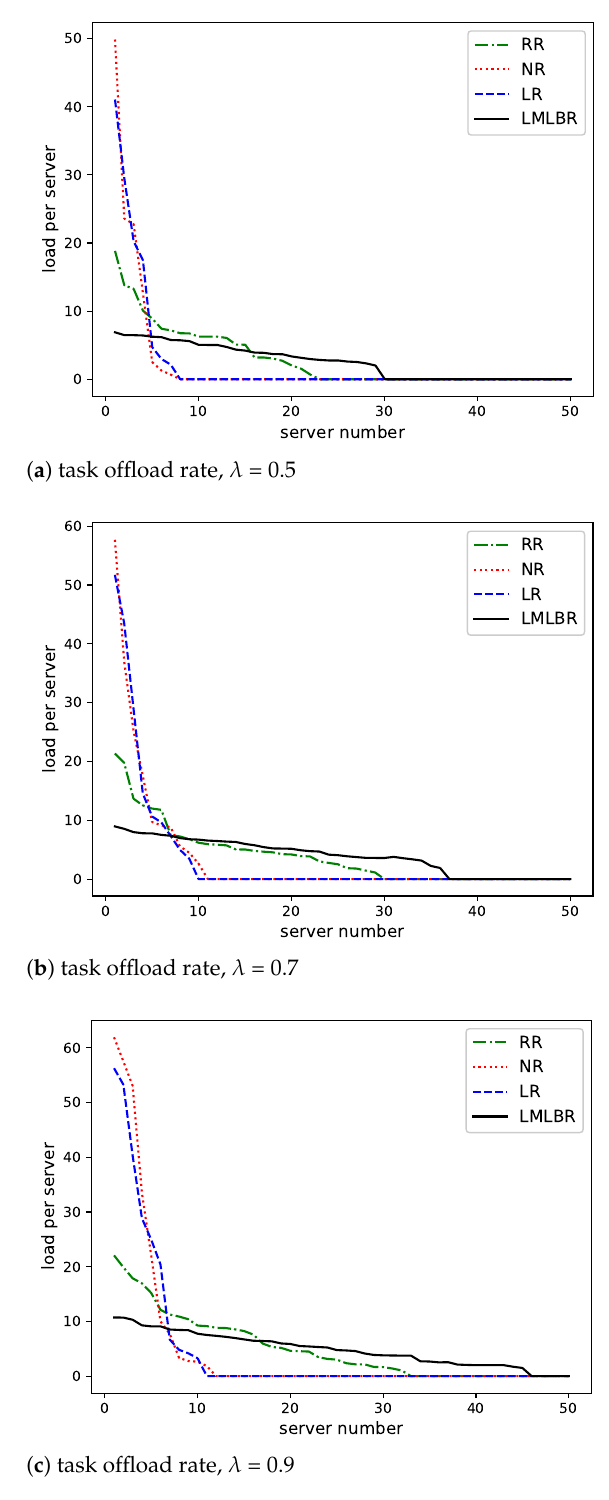
Figure 3. Load per server for a given time slot (i.e., ρ i ( t ) , ∀ i ∈ N